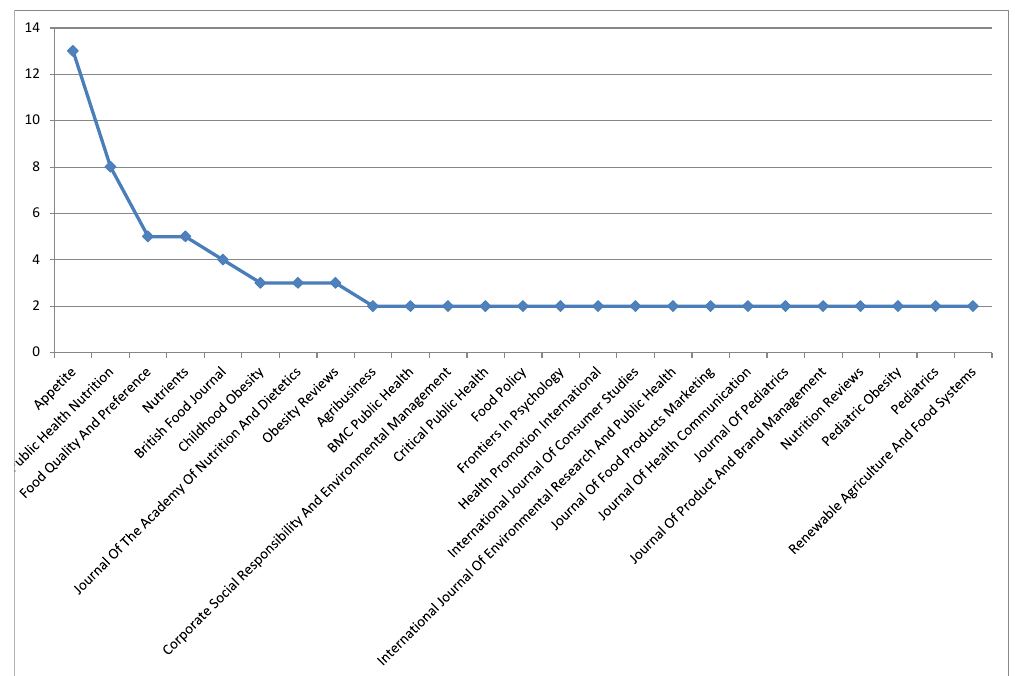
Figure 4. Source titles with two or more documents. Foods 2020 , 9 , x FOR PEER REVIEW